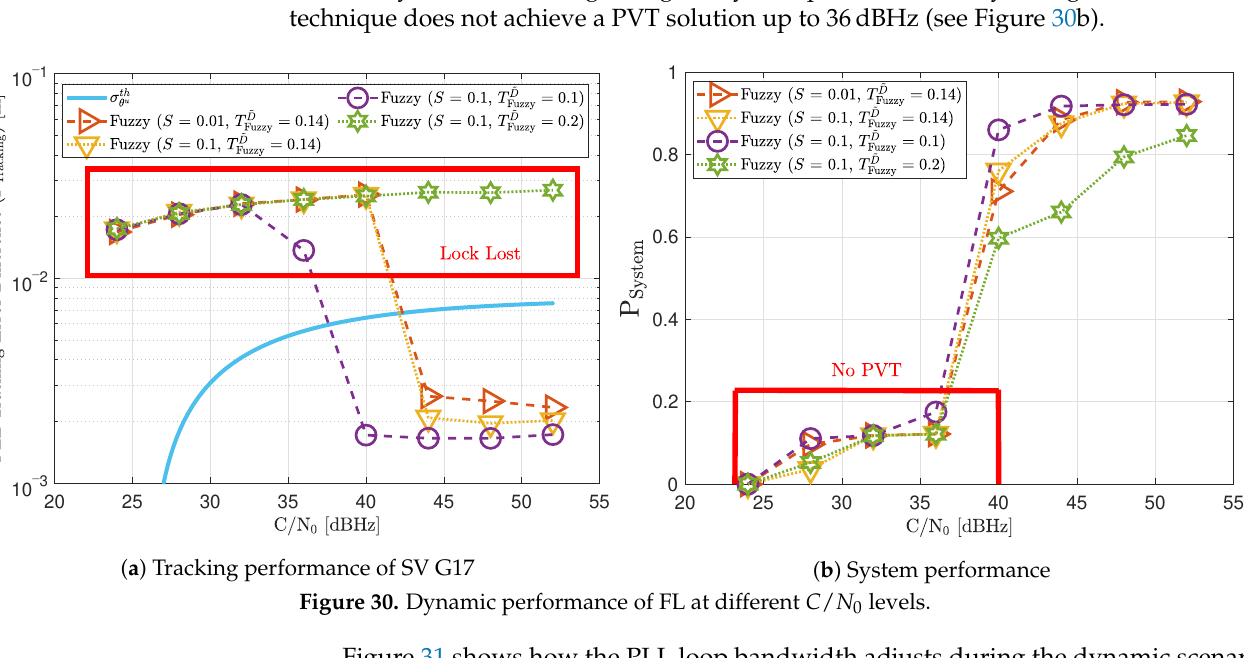
Fuzzy equals Fuzzy = 0.2 do not achieve Fuzzy